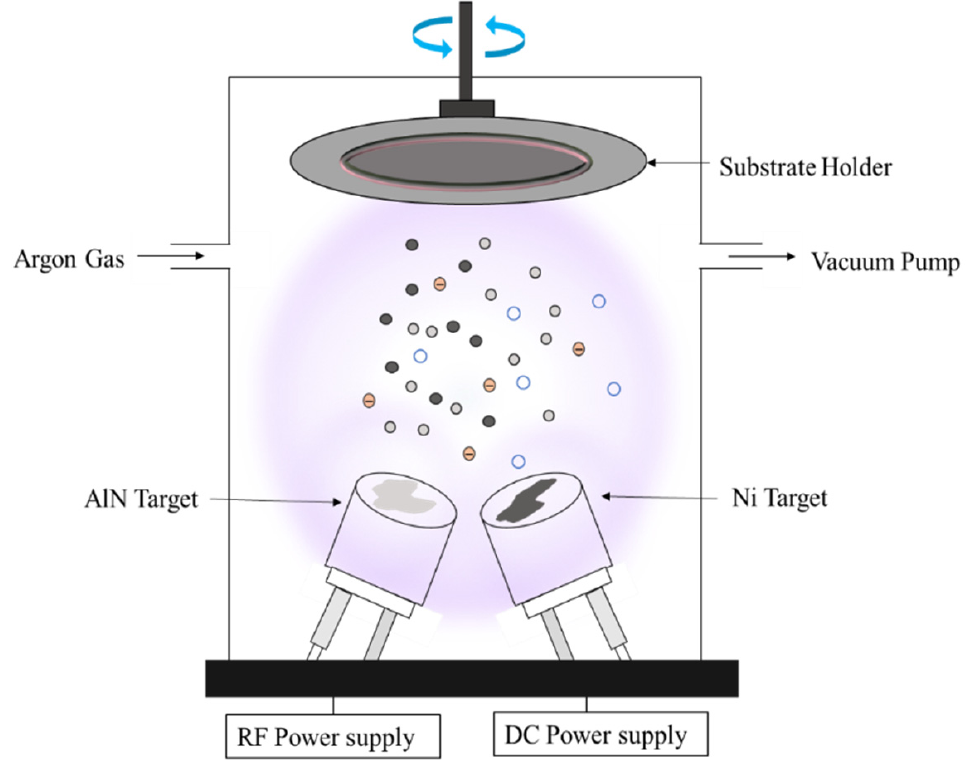
Figure 1. Schematic illustration of